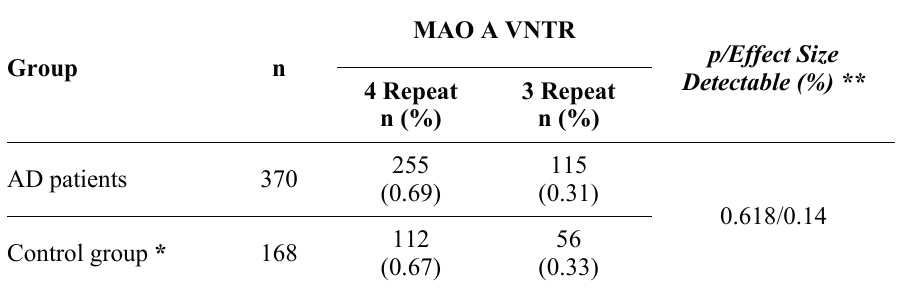
Table 1. Frequency of genotypes of the polymorphism uVNTR of the MAOA gene in patients with alcohol dependence (AD) and in controls.